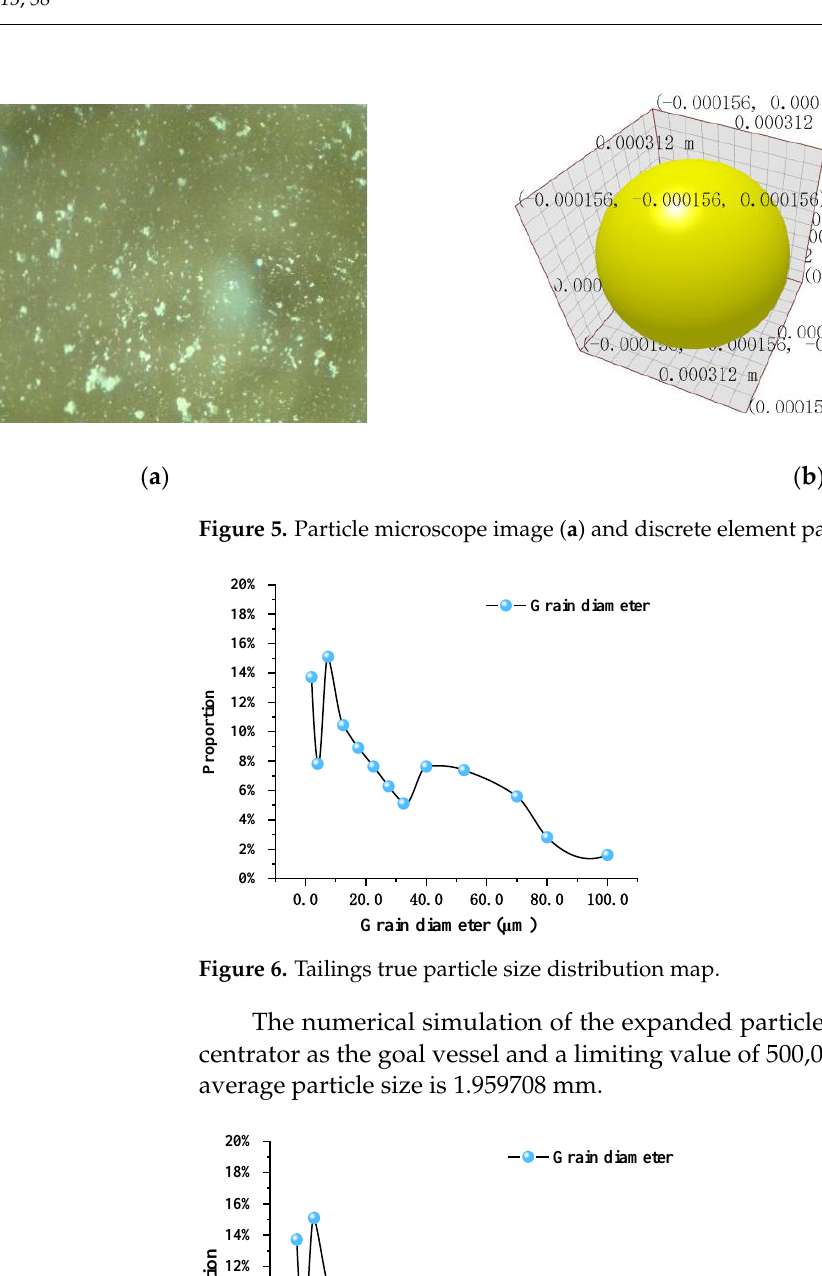
( c ) Figure 8. Schematic diagram of discrete element repose simulation flow. 3. Designing and Analyzing Studies for Parameter Calibration Plackett-Burman and Box-Behnken experiments are combined in the parameter cali- bration experiment. Plackett-Burman analysis [26] reveals that the factor that needs to be calibrated the most has the greatest impact on the angle of repose; the relationship model between the angle of repose and the significant parameters is then obtained by analyzing the significant factors and carrying out the Box-Behnken experiment, and the best param- eters are then examined. Finally, the accuracy is examined by comparison with the actual particle angle of repose and by confirming the viability [27].